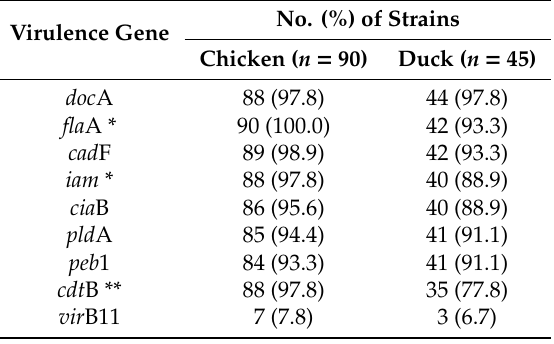
Table 4. Prevalence of virulence genes in C. jejuni strains isolated from retail raw chicken and duck meat in